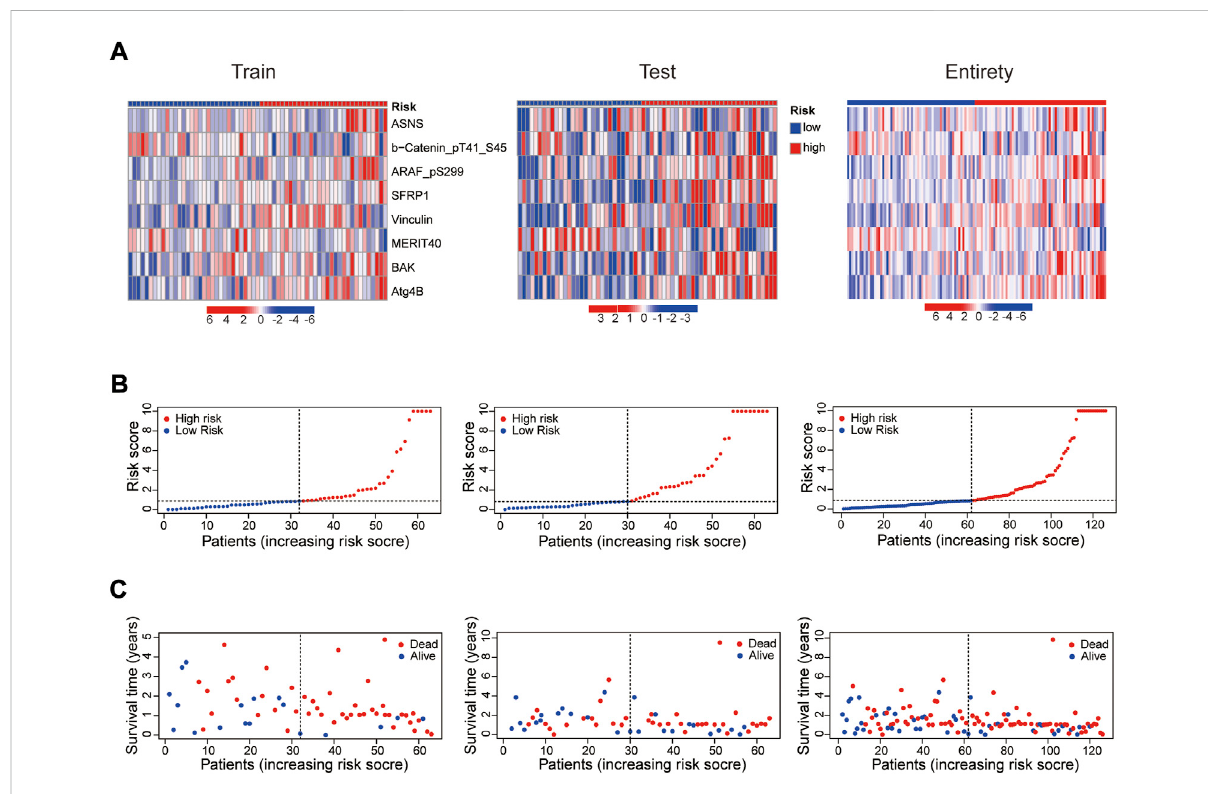
FIGURE 4 Prognosis evaluation of the established protein prognostic risk model. Heat maps of 8 prognostic-related proteins expressions (A) , the distribution of risk scores (B) and the survival time (C) between the high- and low-risk groups in the three